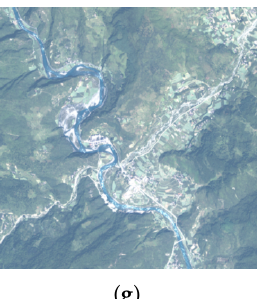
Figure 5. IKONOS original images and Pan-sharpened images by different methods. ( a ) Low-resolution